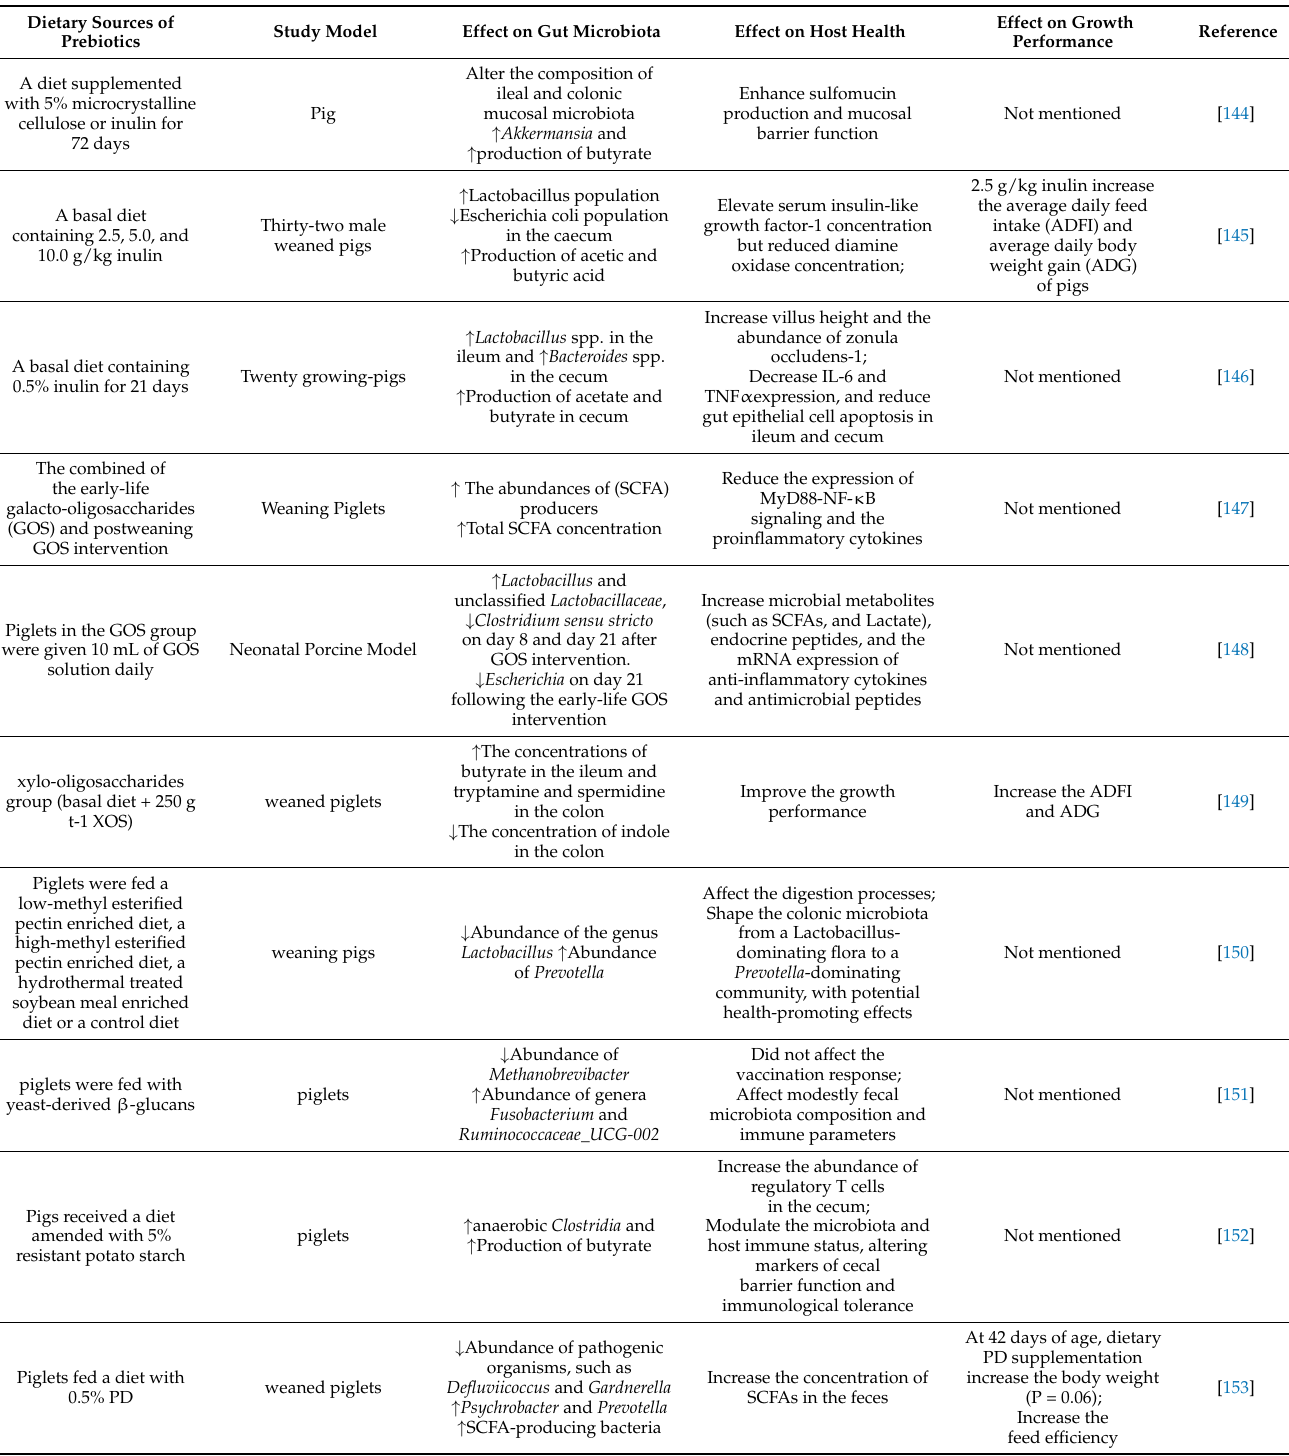
Table 1. Effects of different prebiotics on gut microbiota and their impact on host